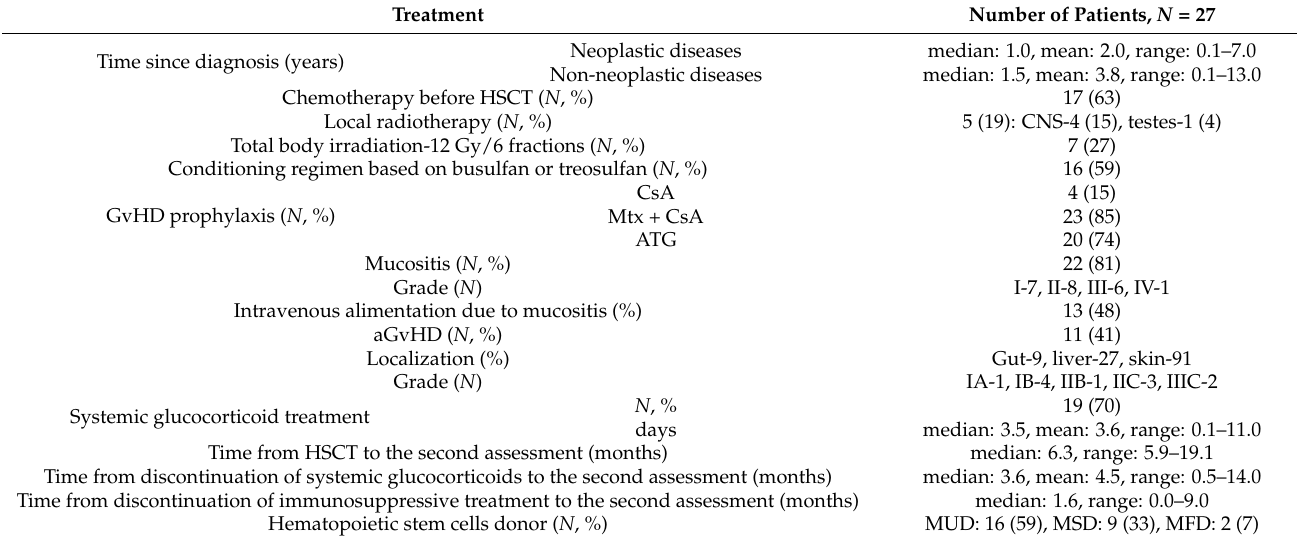
Table 3. The summary of therapeutic interventions in children referred for allogeneic HSCT. Treatment Number of Patients, N = 27 Neoplastic